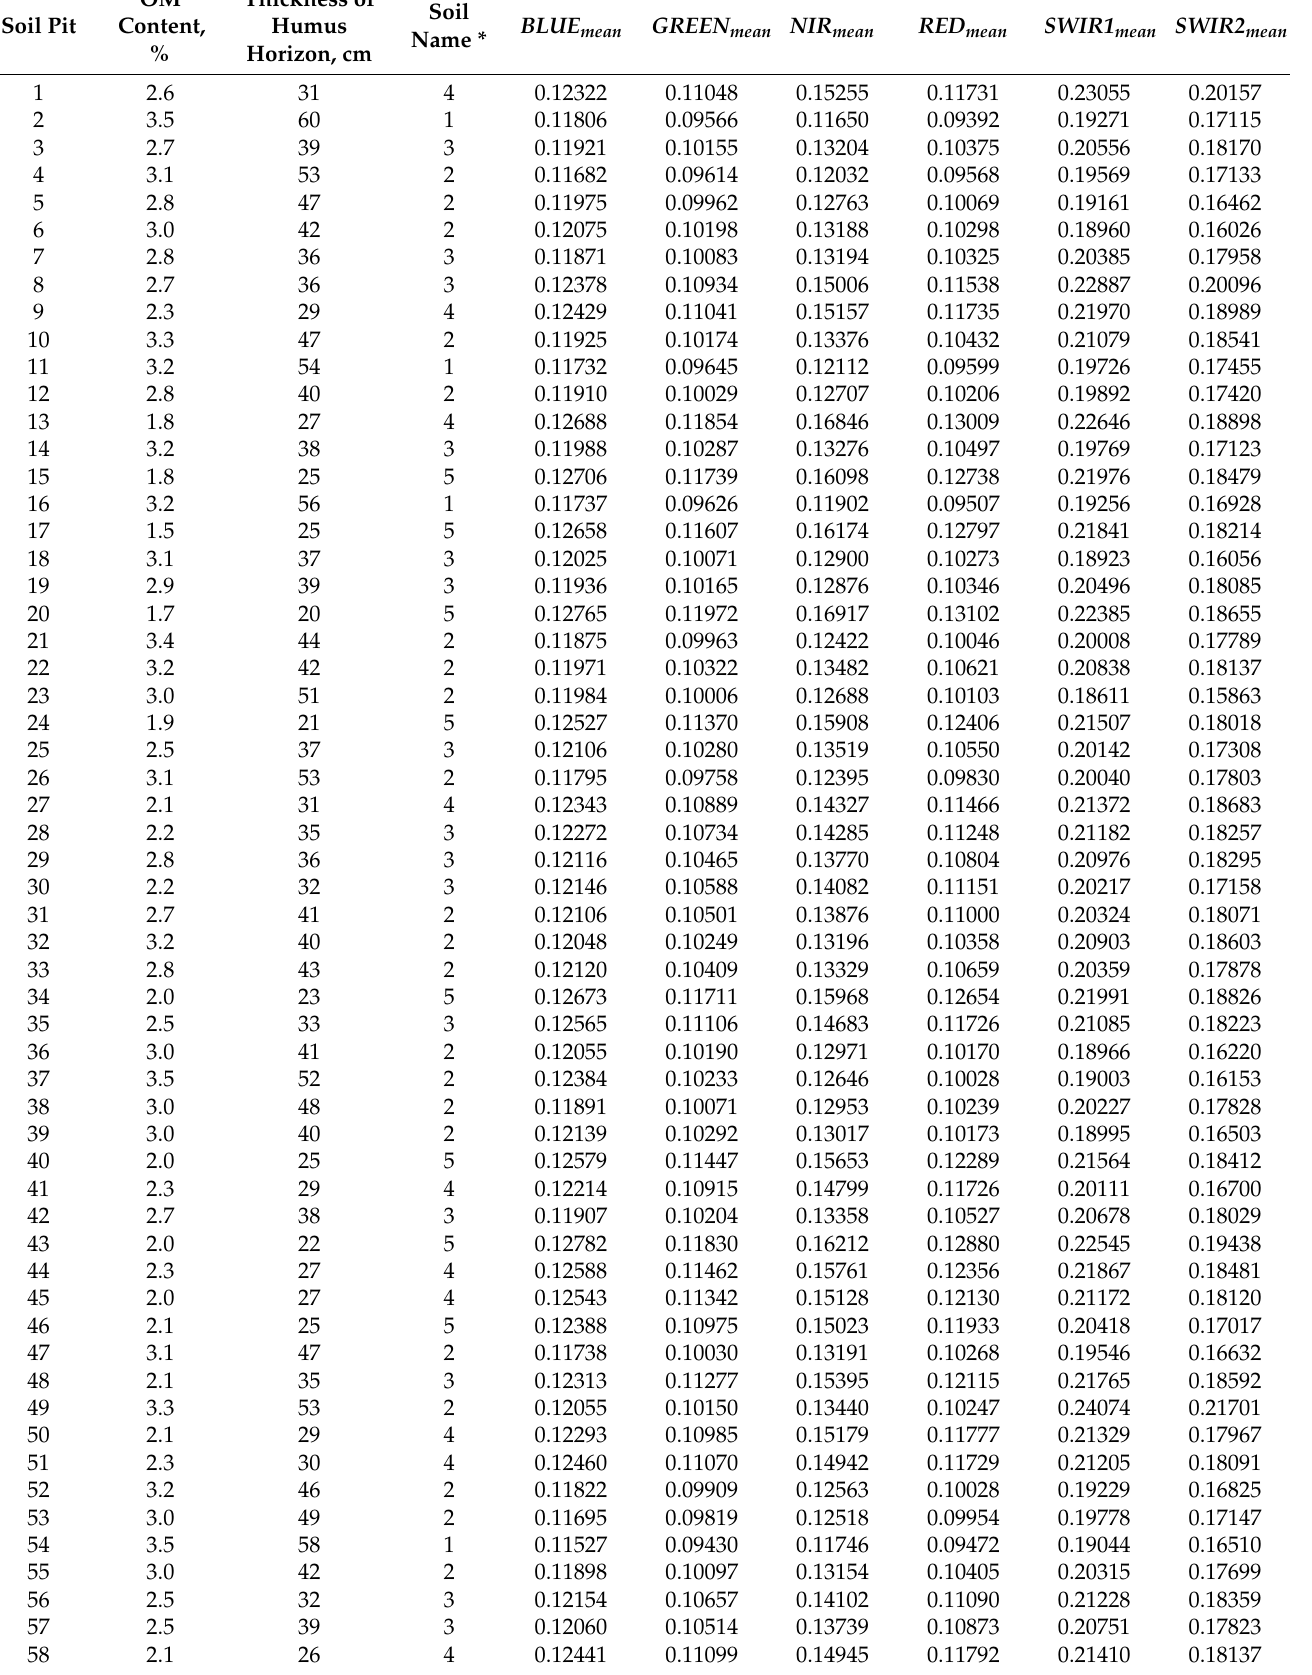
Table 1. Results of ground surveys and BSS long-term average spectral